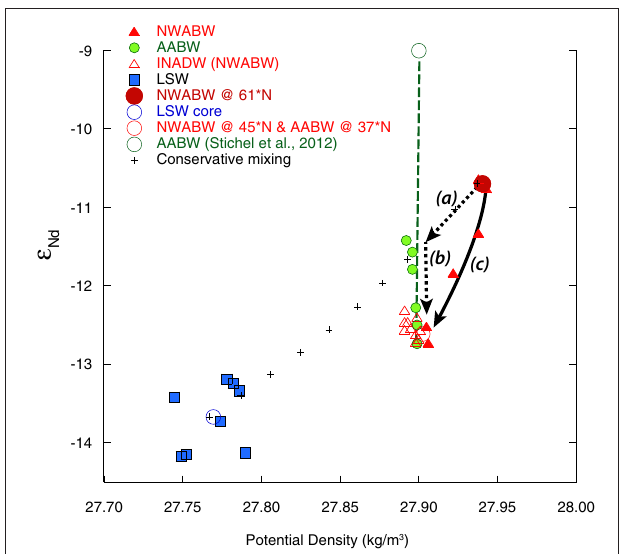
FIGURE 4 | Mixing properties of density and ε Nd . Conservative mixing of ε Nd between NWABW and LSW can explain 1-unit of ε Nd [dashed arrow (a)], leaving 1-unit unexplained [dashed arrow (b)]. Compare to non-conservative alteration via benthic fluxes [solid arrow (c); data from Lambelet et al., 2016]. Note the detached INADW maintains its ε Nd signature as it does potential density. The highly non-conservative nature of ε Nd for AABW is illustrated (green dashed arrow; see text for